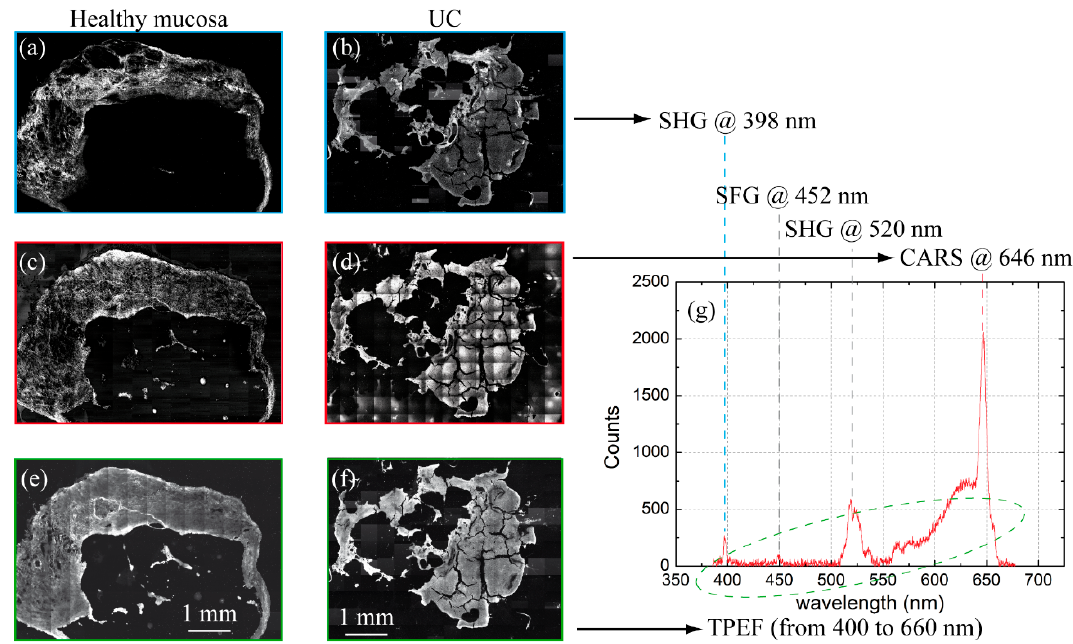
Figure 8. ( a – b ) SHG images acquired with the 797 nm pulsed laser from healthy mucosa and UC respectively, ( c – d ) CARS mapping using both lasers, ( e – f ) TPEF images acquired with 797 nm pulsed laser. ( g ) Multi-photon spectrum, excited with synchronized pulsed lasers emitting at 797 nm and 1040 nm, presenting two narrow SHG signals at 398 and 1040 nm respectively, a peak at 452 nm due to the Sum Frequency Generation (SFG) process, CARS peak at 646 nm and the fluorescence which is broad and covers the 400-650 nm range. The spectrum is very attenuated in the first half due to the optics, which are optimized for the Raman signals in the near infrared, while the cut around 665 nm is due to the dichroic for the signal collection.